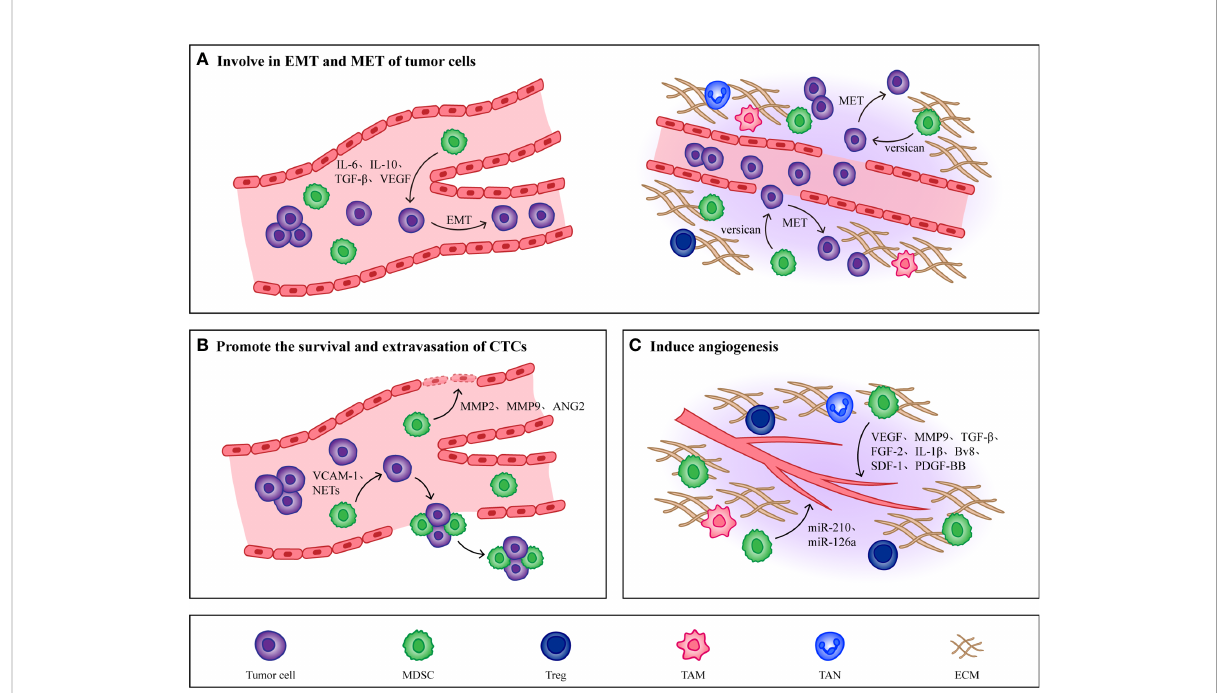
FIGURE 3 Non immunological effects of MDSCs. (A) MDSCs promote EMT of tumor cells by producing IL-6, IL-10, TGF- b and VEGF, which makes tumor cells obtain high migration and invasion ability. When CTCs reach the host organ, MDSCs will induce CTCs to undergo MET, restore their epithelial phenotype and promote their proliferation. (B) MMP2, MMP9, VEGF and Ang-2 produced by MDSCs effectively increase the permeability of blood vessels and are conducive to the extravasation of CTCs. At the same time, MDSCs combine with CTCs through VCAM-1 and NETs to form CTC/MDSC clusters, which promote the survival and extravasation of CTCs. (C) MDSCs promote angiogenesis in PMN by producing cytokines such as VEGF, MMP9, TGF- b and FGF-2. In addition, MDSCs derived exosomes miR-126a and miR-210 also induce